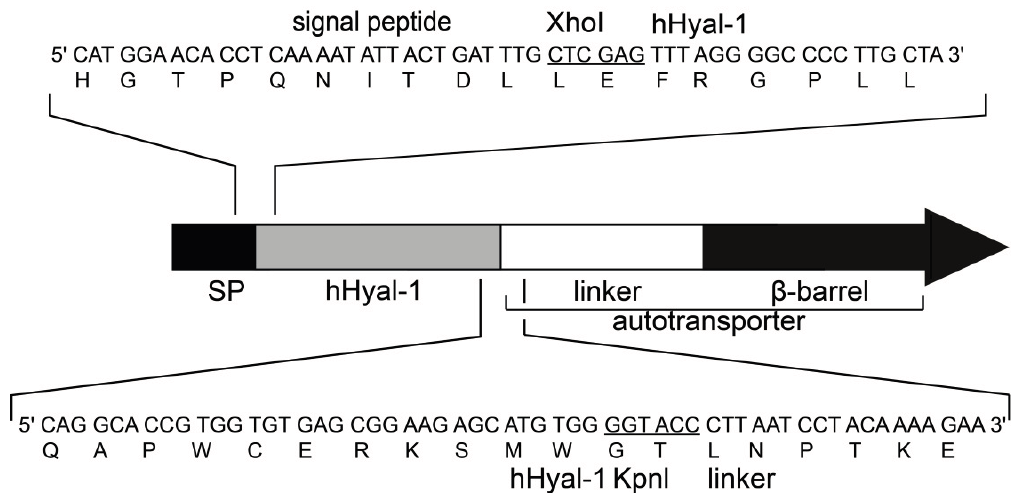
Figure 1. Schematic structure of the Hyal-1 autotransporter fusion protein. The DNA- and amino acid sequences are plotted. Restrictions endonucleases recognition sites for Xhol and